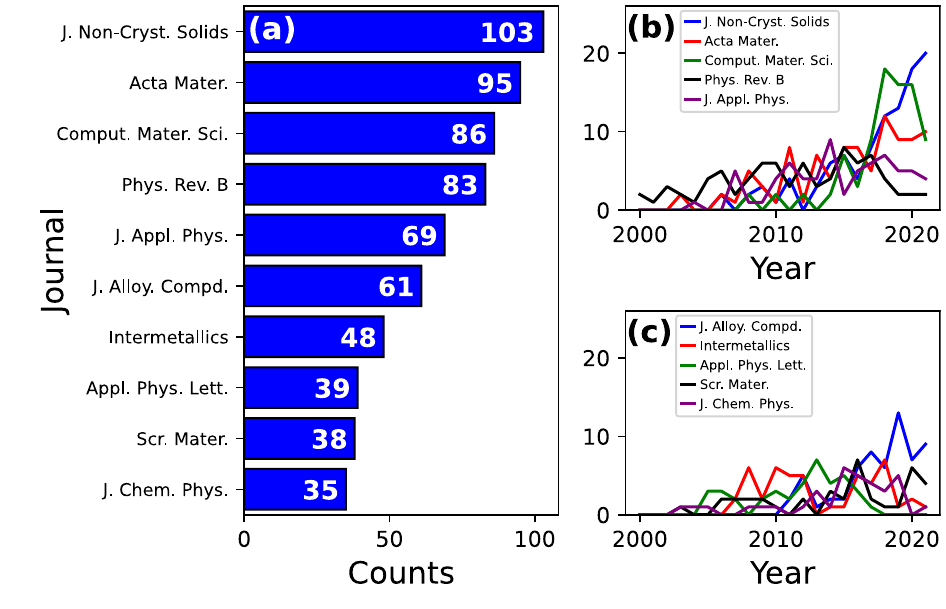
Fig. 3 a Top ten journals with higher numbers of publica- tions. b , c Evolution of the number of publications for